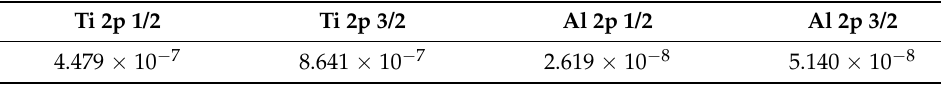
Table A3. Calculated peak